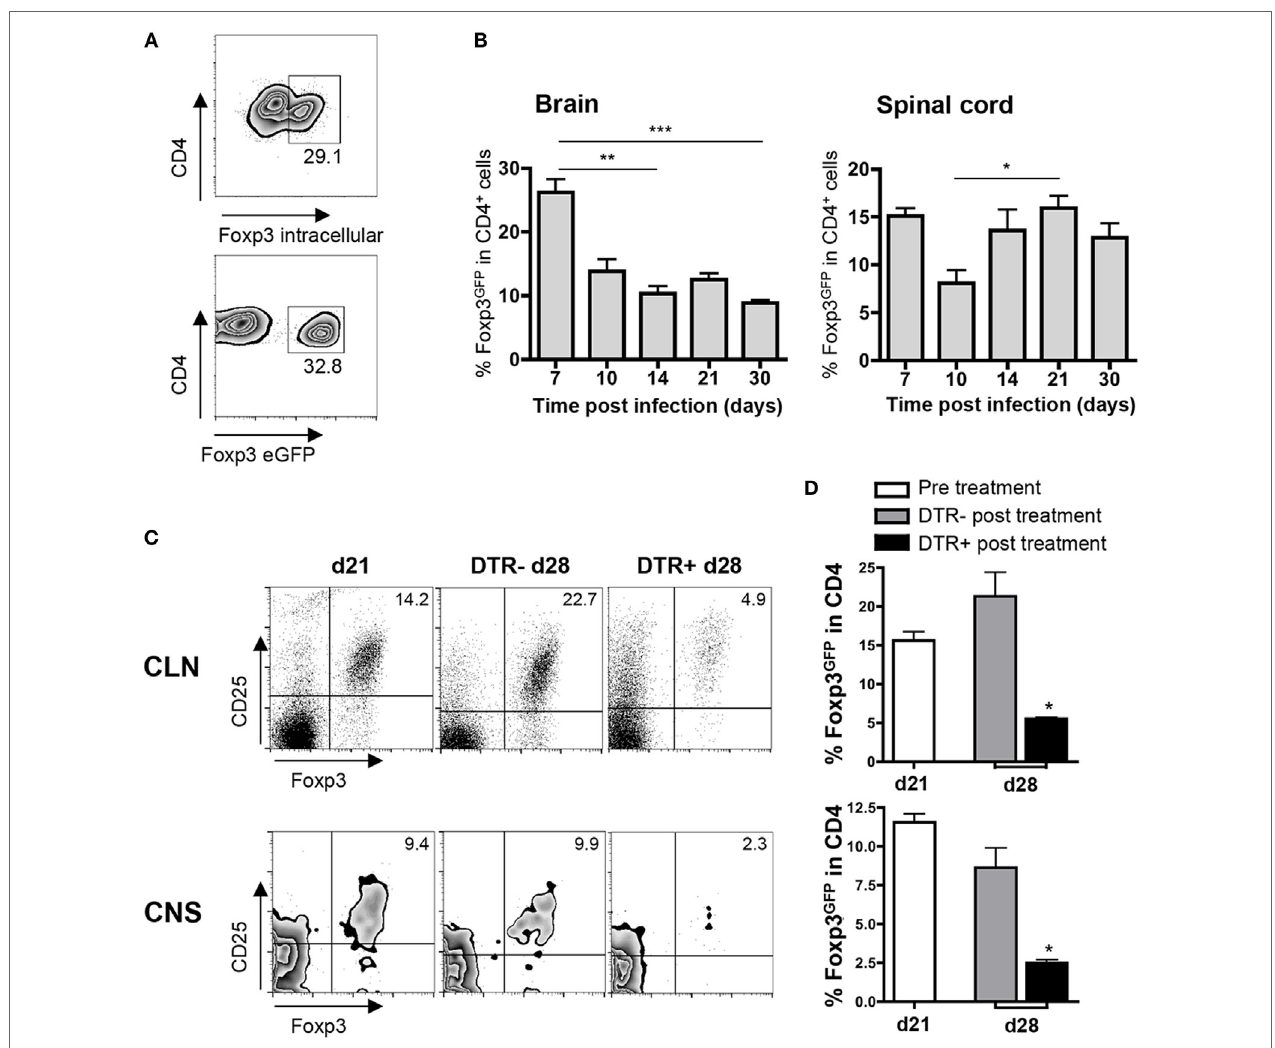
FigUre 1 | Kinetics of cns localized Foxp3 + Tregs and depletion in infected DT-treated Dereg mice . (a) Representative flow cytometry density plots depicting intracellular Foxp3 and eGFP staining in brain-derived CD4 + T cells from WT and DEREG mice, respectively, at day 7 p.i. (B) Frequencies of Foxp3 + cells in CD4 + T cells derived from brain and spinal cord of infected DEREG mice between days 7 and 30 p.i. Data represent the mean ± SEM of three separate experiments with n = 3 per time point per experiment. * p < 0.05, ** p < 0.01, *** p < 0.001, Dunn’s multiple comparison test (c) Representative flow cytometry plots depicting Foxp3 + CD25 + cells gated on CD4 + T cells from CLN and CNS before (d21 p.i.) and after (d28 p.i.) DT treatment of DTR − and DTR + mice. (D) Percentage of Foxp3 + cells in CD4 + T cells from CLN (top) and CNS (bottom) before (d21) and after (d28) DT treatment in DTR − and DTR + mice. Data represent the average ± SEM of four individual experiments. * p < 0.05, Mann–Whitney